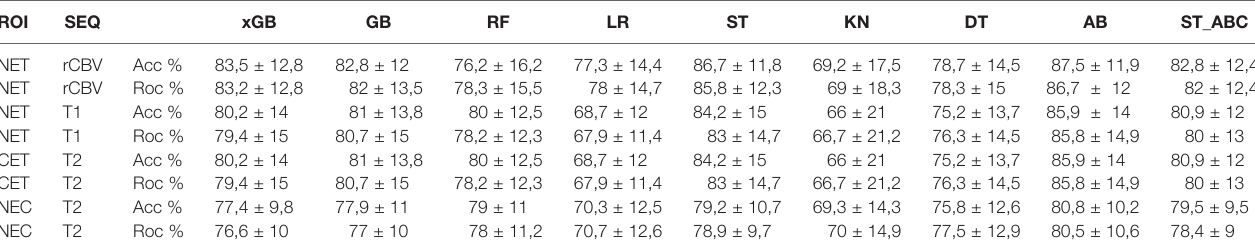
TABLE 4 | IDH best results (reported as mean ± standard